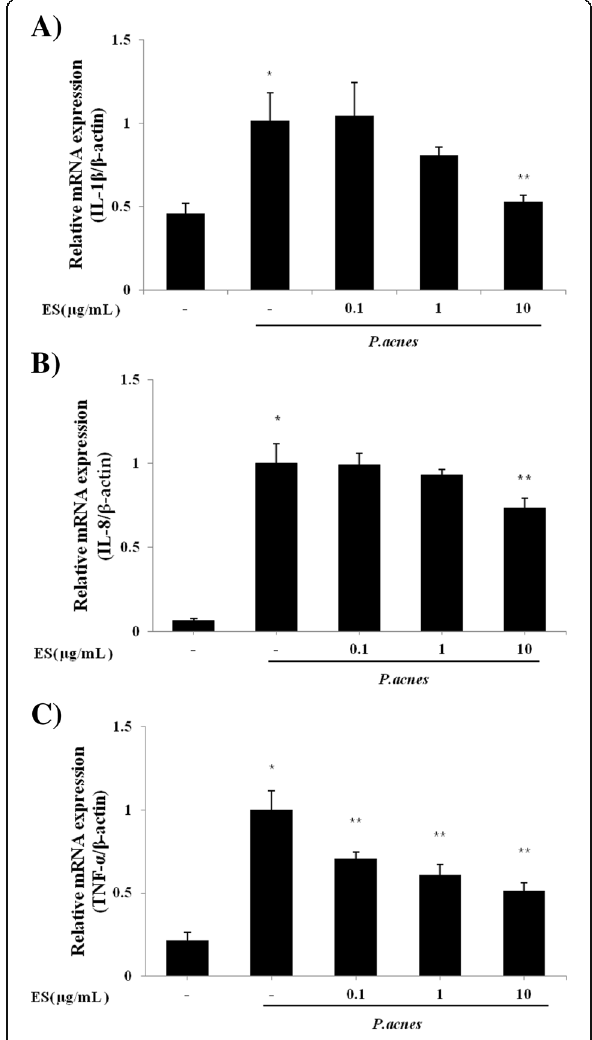
Fig. 3 Effect of ES on the gene expression of ( a ) IL-1 β , ( b ) IL-8 and ( c ) TNF- α in P. acnes -induced THP-1 cells. The expression level of mRNA was determined using a Real-time PCR. THP-1 cells were pre- treated with 0.1, 1 and 10 μ g/ml of ES for 4 hrs incubation and then stimulated with P. acnes for 18 hrs incubation. Values represent mean ± S.E.M. Data were analyzed by Tukey post hoc test ( * p < 0.05 versus control and ** p < 0.05 versus P.acnes